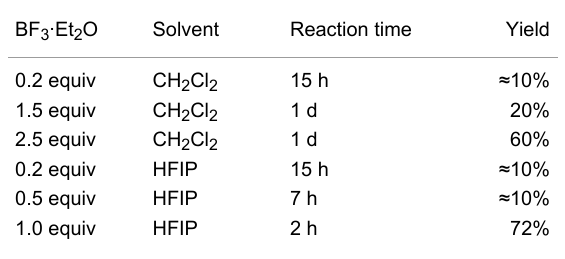
Table 1: Optimization of Aubé reaction